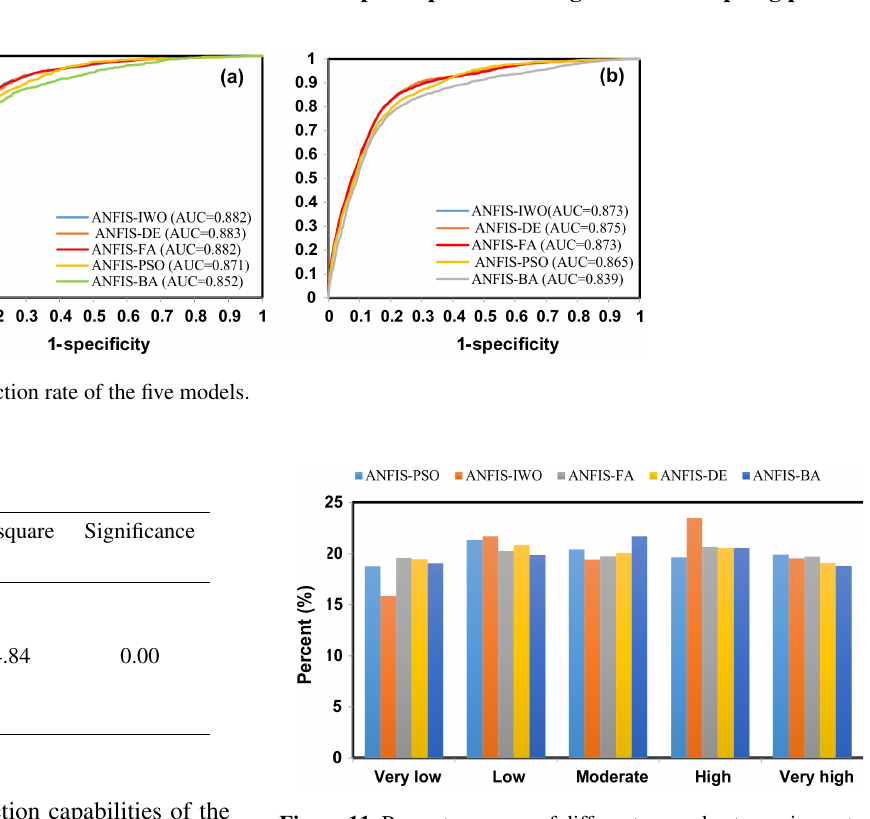
Figure 11. Percentage areas of different groundwater spring poten- tial classes for five